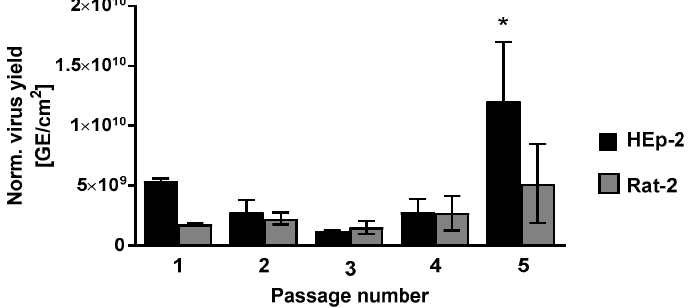
Figure 1. Virus yield during CPXV crust passaging reveals a replication gain in human cells. Viral genome equivalents (GE) of passaged CPXV crust were determined by qPCR after cell lysis. Shown are mean values ± standard deviation (SD) of normalized virus yield. Statistics: One-way analysis of variance and Bonferroni’s multiple comparisons test (* p ≤ 0.05).